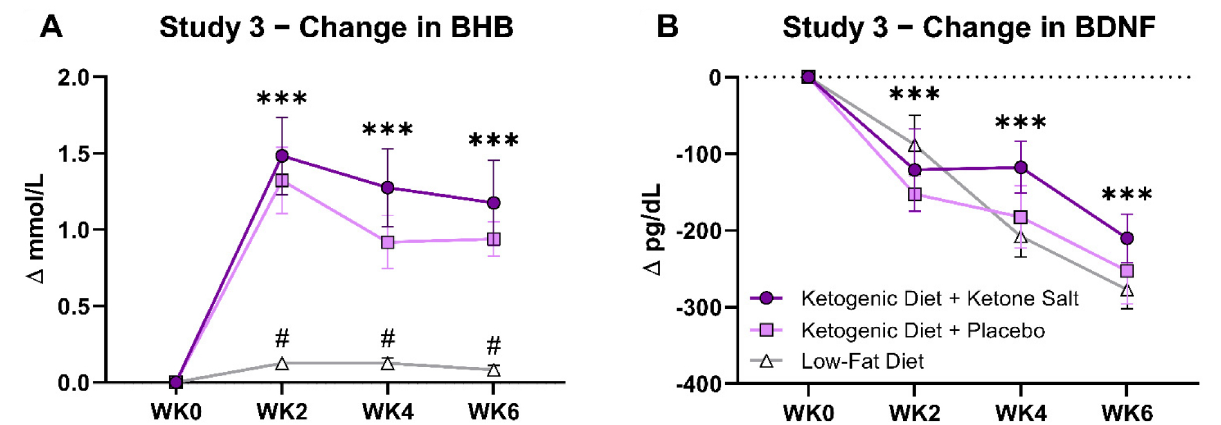
Figure 3. Study 3 BHB and BDNF Changes. In both KD groups, fasted capillary BHB increased progressively to concentrations above 1.0 mmol/L by WK2 and stayed elevated throughout the 6-week intervention. Fasting BHB was higher in KD + KS at WK1 and WK2 but was similar to KD + PL thereafter ( A ). Plasma BDNF was calculated using a 3 (diet) × 4 (time) repeated measure analysis of variance (ANOVA). Plasma concentrations of BDNF decreased significantly from baseline starting at WK2 ( ∆ = − 121 ± 20 pg/dL; − 17%; p < 0.001), then continued to decrease through WK4 ( ∆ = − 170 ± 20 pg/dL; − 26%; p < 0.001) and WK6 ( ∆ = − 247 ± 20 pg/dL; − 39%; p < 0.001) ( B ). Time effects: *** p < 0.001 from WK0. # = different than KD ( p < 0.05). WK0, week 0; WK2, week 2; WK4, week 4; WK6, week